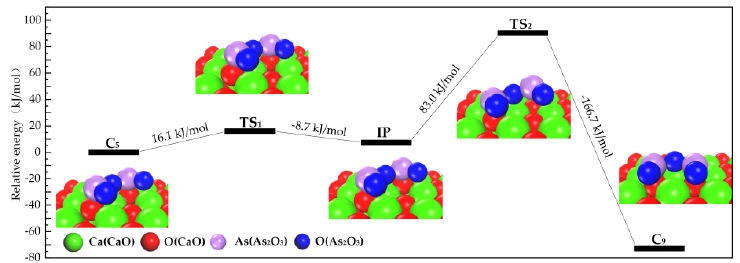
Figure 3. Transformation path of Category II.